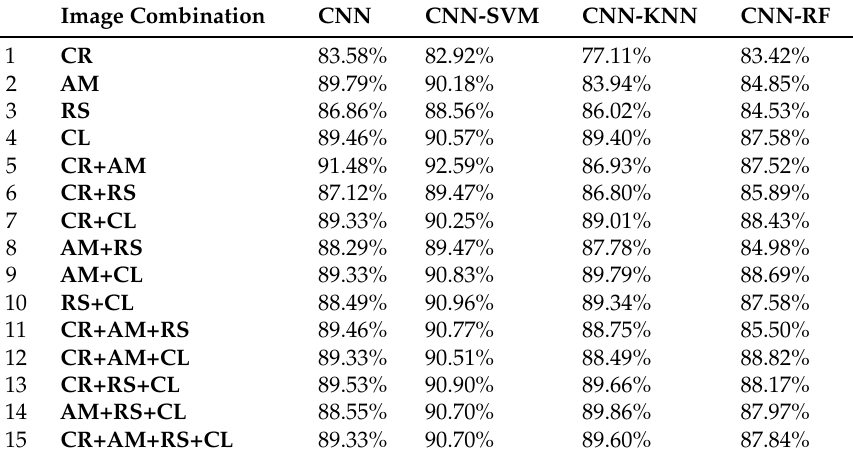
Table 4. Accuracy of generic and augmented CNN on 15 different combinations of grayscale malware images.